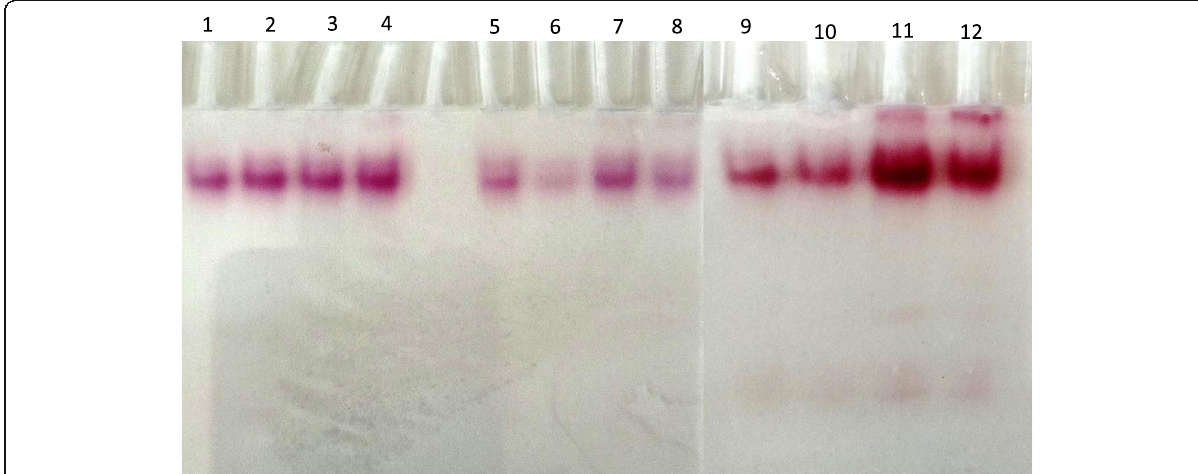
Fig. 4 Electrophoretic patterns of the peroxidase isozymes for the three lentil cultivars (G1, G2, G3) under control and treatment with different EMS doses. Lane 1 = G1 (control), lane 2 = G1 (0.1 EMS), lane 3 = G1 (0.2 EMS), lane 4 = G1 (0.3 EMS), lane 5 = G2 (control), and lanes 6, 7, and 8 = G2 with 0.1, 0.2, and 0.3 EMS, respectively. Lane 9 = G3 (control) and lanes 10, 11, and 12 = G3 with 0.1, 0.2, and 0.3 EMS doses,